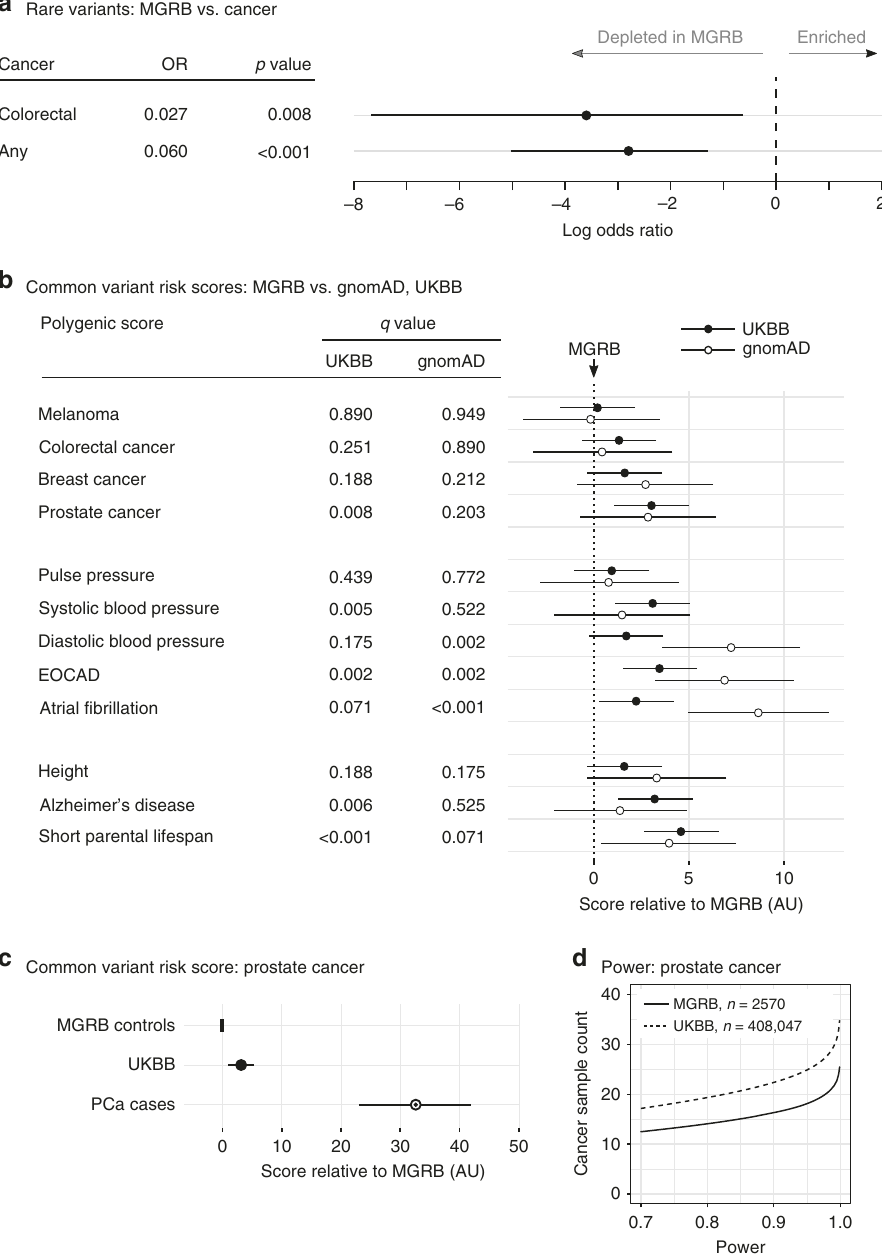
cancer-free cases in the MGRB, and individuals from the 45 and Up cohort with these cancers (Supplementary Table 4). Con- sistent with the relative depletion of rare cancer variants in the MGRB observed above, MGRB individuals had signi fi cantly lower polygenic risk scores than cases for prostate cancer (as above, n = 71 cases, n = 278 MGRB gender- and cohort- matched controls, t = 3.96, df = 126, two-sided p < 0.001, Fig. 2a)